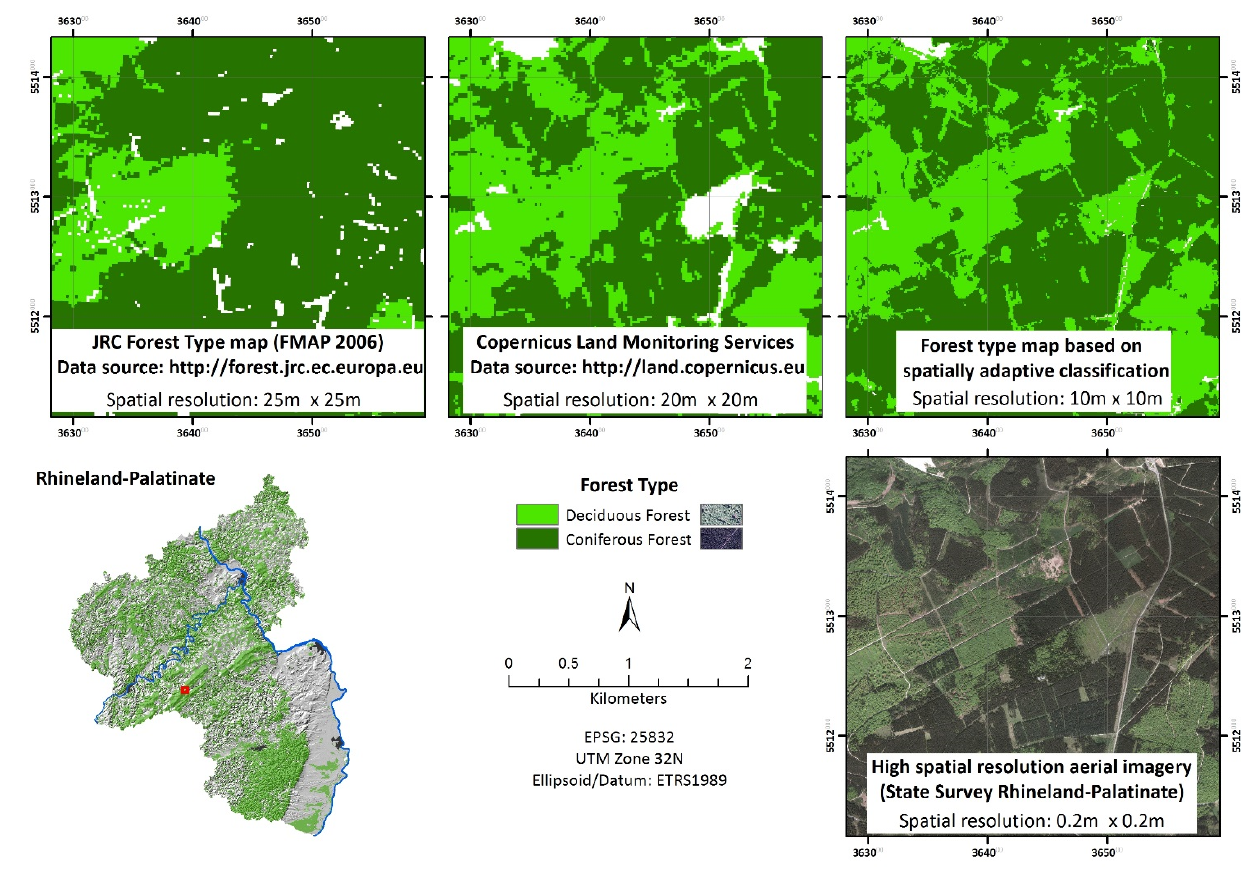
Figure 5. Map views of JRC forest-type map 2006, Copernicus high-resolution layers (forest type), and the spatially adaptive classification product in comparison with high spatial resolution aerial imagery of a densely forested area in the Hunsrück low-mountain